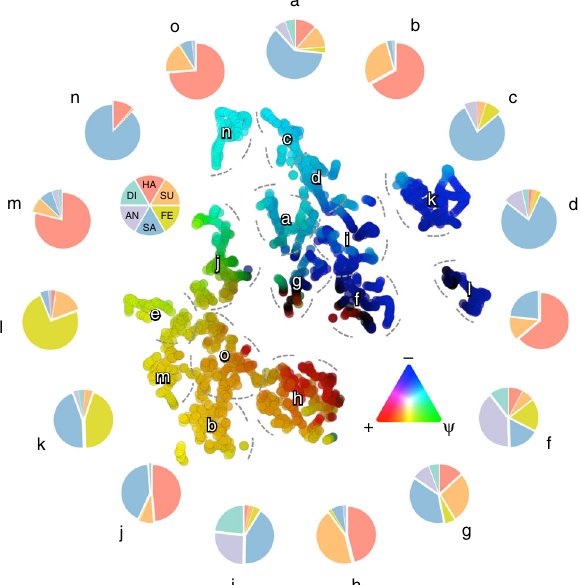
Fig. 2 Richness of the emotional experience. Results of the dimensionality reduction (t-SNE) and clustering analyses (k-means) on the group- averaged behavioral ratings showing the existence of 15 distinct affective states throughout the movie. Each element represents a speci fi c timepoint in the movie and the distance between elements depends on the statistical similarity of emotion ratings. Element color re fl ects the scores of the polarity and complexity dimensions: positive ( + ) and negative ( − ) events (i.e., polarity) are associated, respectively, to the red and blue channels, whereas complexity ( Ψ ) scores modulate the green channel. Pie charts show the relative contribution of the six basic emotions to each of the 15 identi fi ed clusters. Combinations of distinct emotions likely express secondary affective states, as ambivalence (i.e., cluster j depicting movie scenes in which happiness and sadness are simultaneously experienced) or resentment (i.e., cluster i representing movie segments in which a mixture of sadness, anger and disgust is perceived). Of note, this evidence is also supported by single-subject reports, in which the 38% (SE: ±2.3%) of timepoints were associated to a single emotion, the 29% (SE: ±3.5%) to two basic emotions and the 6% (SE: ±1.4%) to the concurrent experience of three distinct emotions. HA happiness, SU surprise, FE fear, SA sadness, AN anger, DI dimensions, voxels seemed to encode polarity and intensity in a